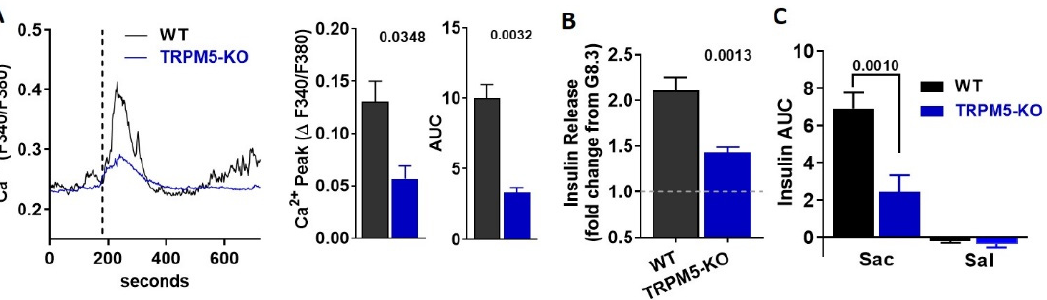
Figure 5. Ablation of TRPM5 abolishes the effects of saccharin in mouse islets and in vivo. ( A ) Representative traces of intracellular calcium response in WT and TRPM5-KO primary beta-cells treated (vertical line) with saccharin (25.0 mM) in the presence of 8.3 mM glucose (n = 3 mice per group; average of 5–10 cells). Insets: calcium response shown as change between baseline and peak calcium response. Area under curve (AUC) calculated as response X time. Two-tailed unpaired T -test. ( B ) Static insulin release in response to saccharin (20 mM) in the presence of 8.3 mM glucose in WT and TRPM5-KO islets (n = 6 mice per group). Data are expressed as fold change from 8.3 mM glucose (set at value 1) using paired experiments. Two-tailed unpaired T-test. ( C ) Plasma insulin in response to a bolus of saccharin (sac; 1.0 g/kg) or saline (sal) injected in WT and TRPM5-KO (n = 5 mice per group). Area under curve (AUC) calculated between 0 to 10 min. ANOVA Fisher’s LSD post hoc.